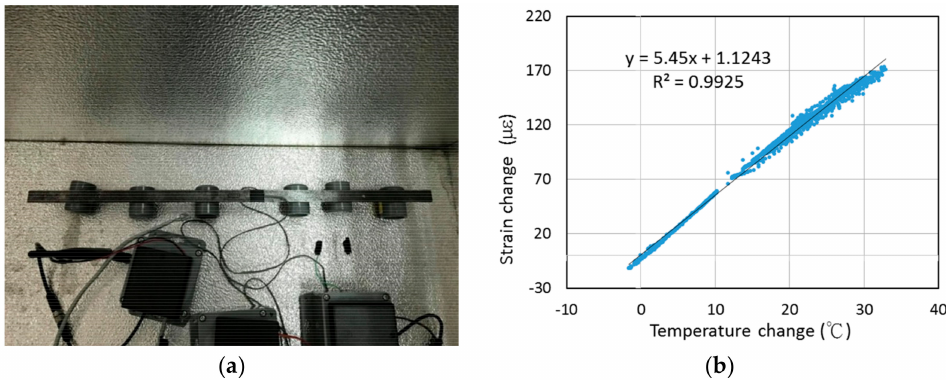
Figure 2. The combined temperature e ff ect coe ffi cient γ value test of a strain gauge (FLA-10) attached to the steel beam: ( a ) temperature-controlled box test; ( b ) strain change and temperature change